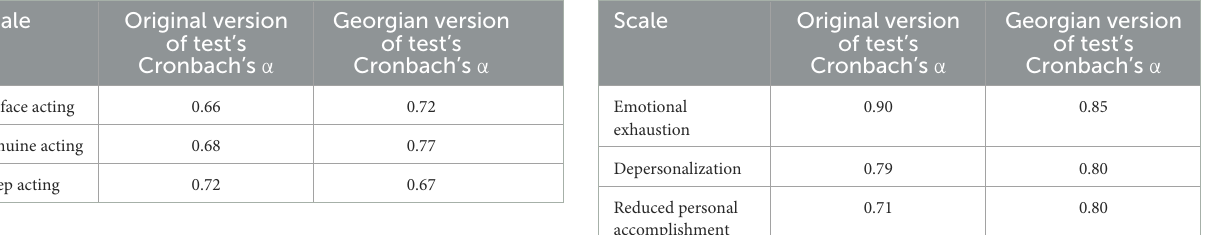
TABLE 1 Reliability of Emotional Labor scale. TABLE 2 Reliability indicators of the MBI-GS